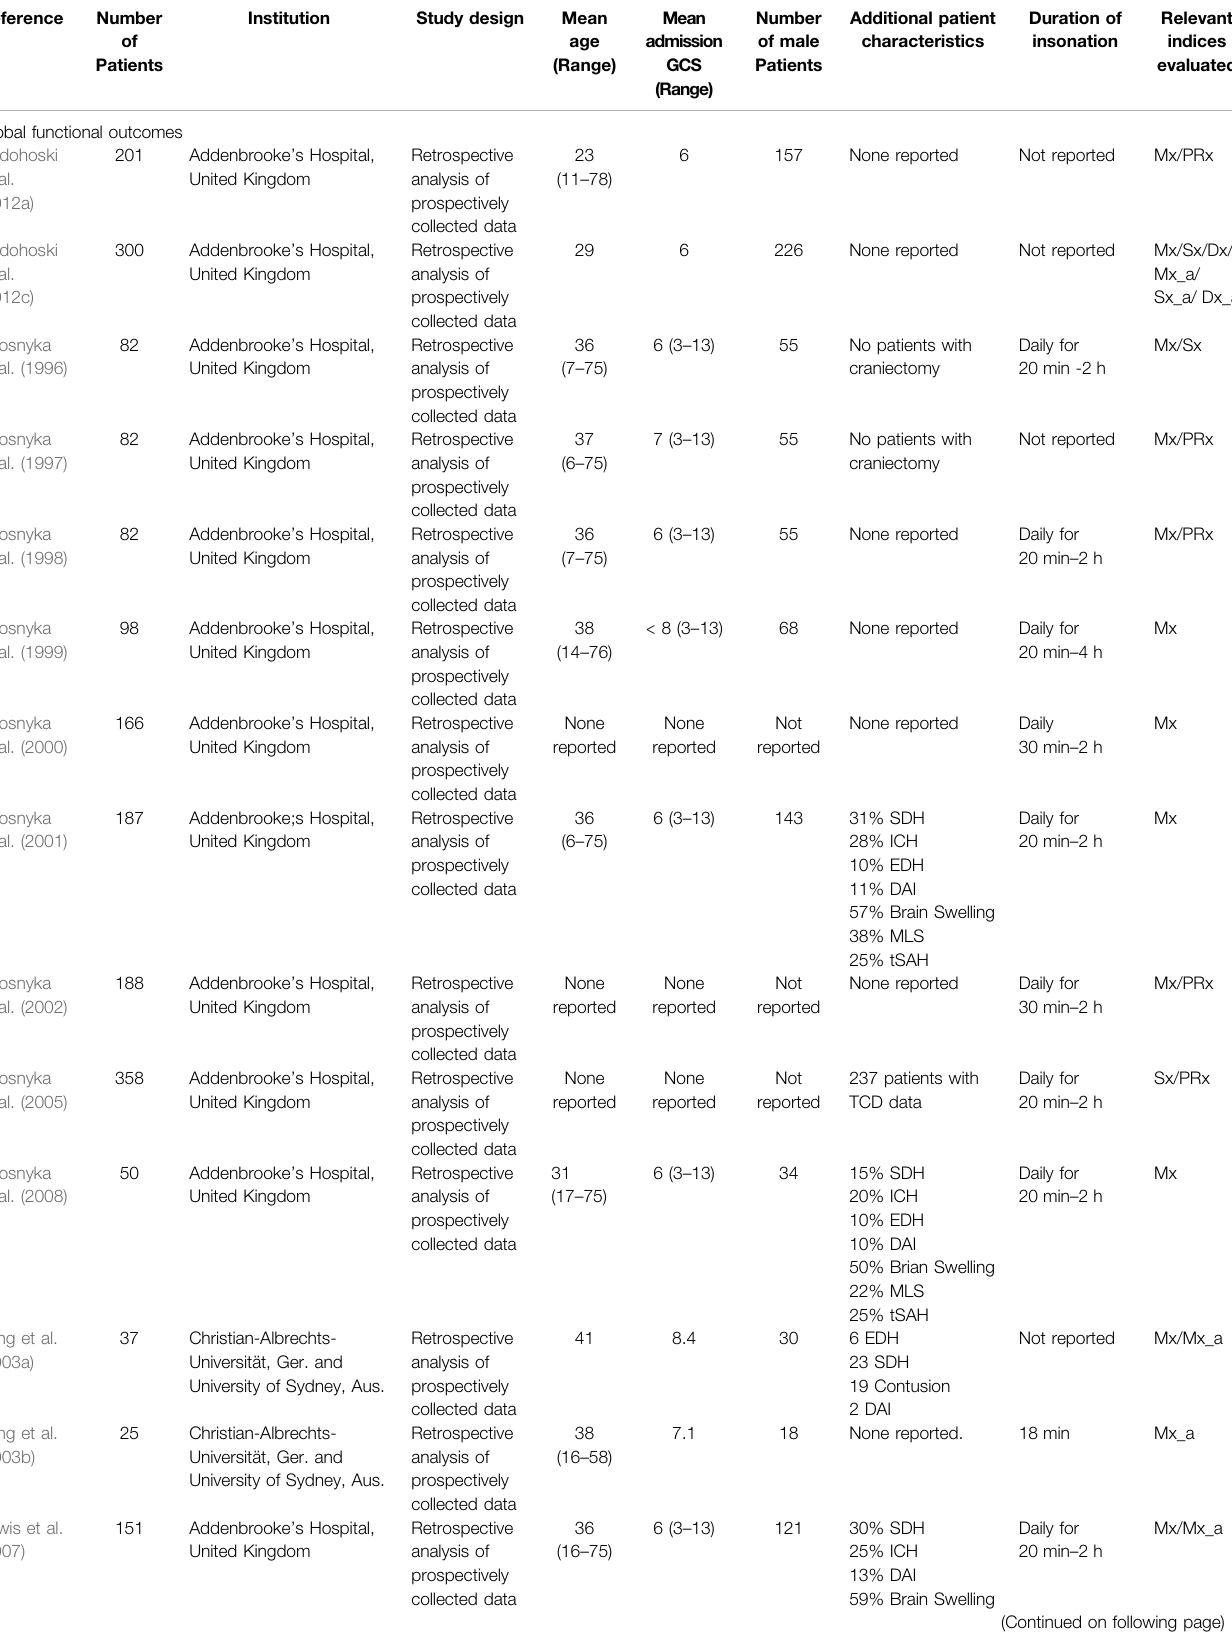
TABLE 3 | Study Characteristics of Included